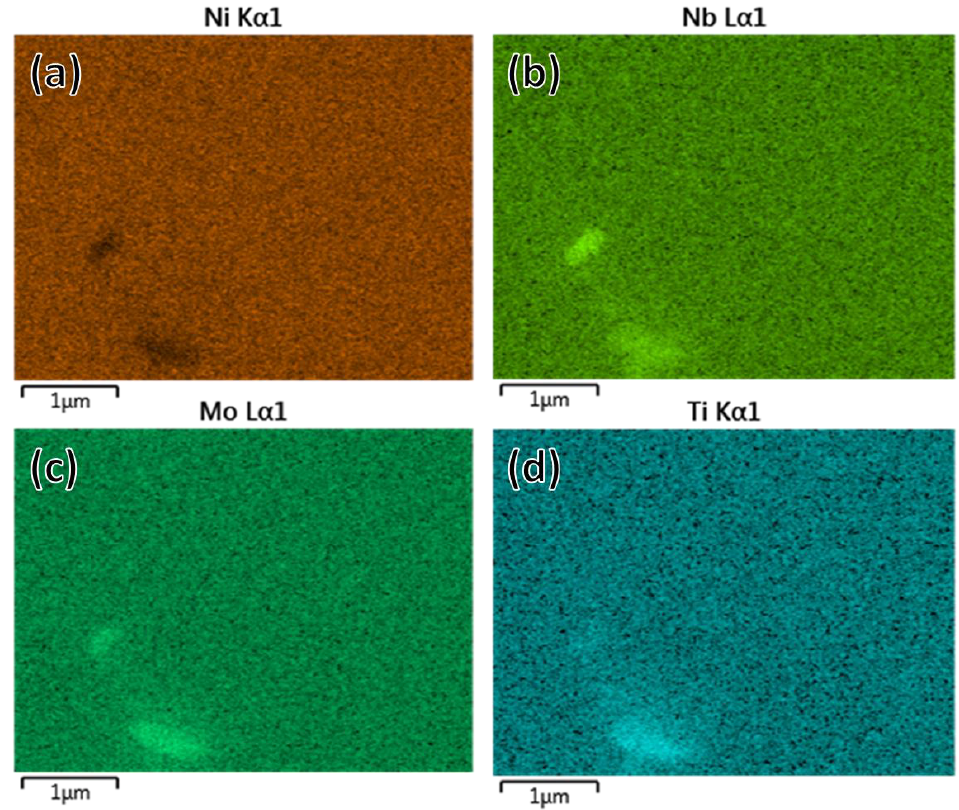
Figure 9. The images show the results of the chemical mapping. ( a ) Ni distribution, ( b ) Nb distribu- tion, ( c ) Mo distribution, ( d ) Ti distribution. tion, ( c ) Mo distribution, ( d ) Ti